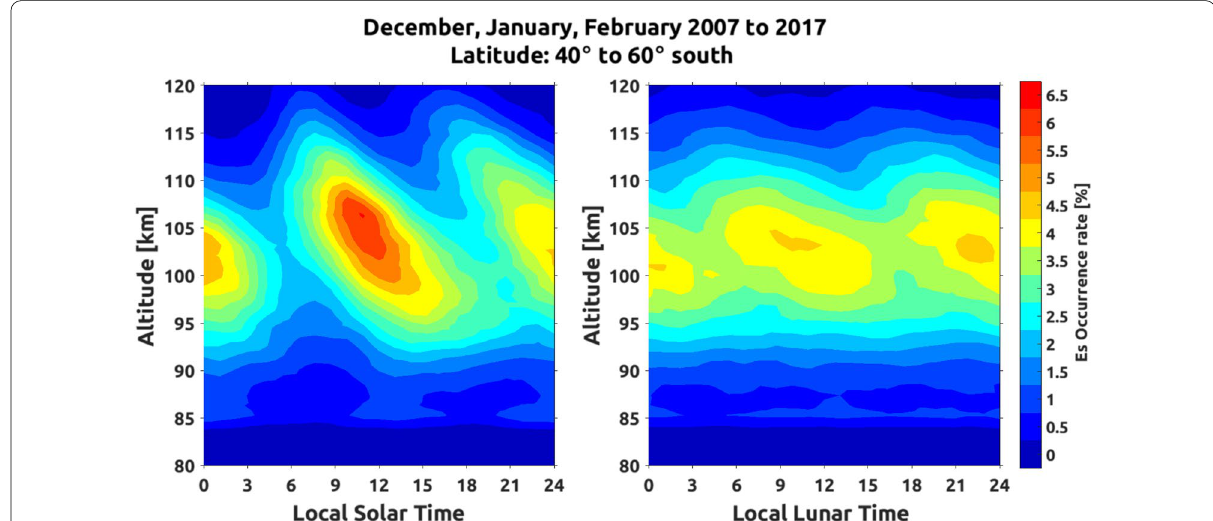
Fig. 2 Mid‑latitude EsOR variations during southern hemisphere summer with solar local time (left) and lunar local time (right) at different altitudes